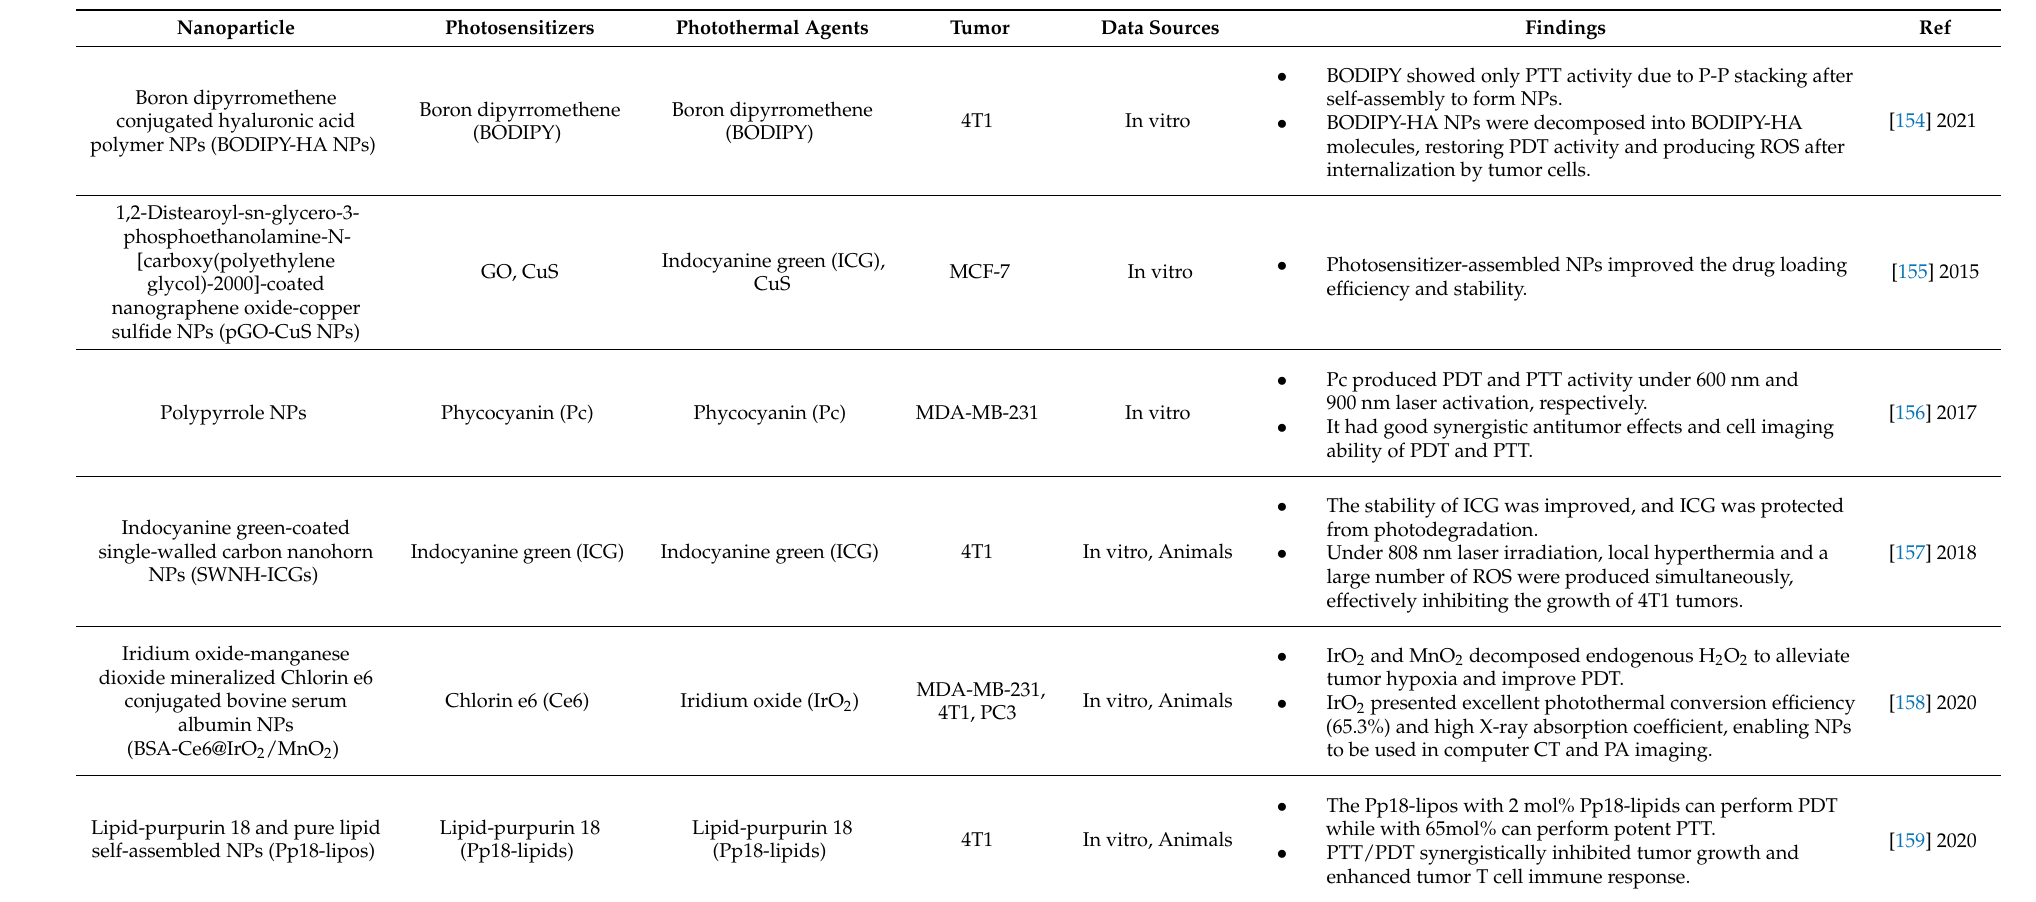
Table 4. Codelivery of photosensitizers and photothermal agents based on